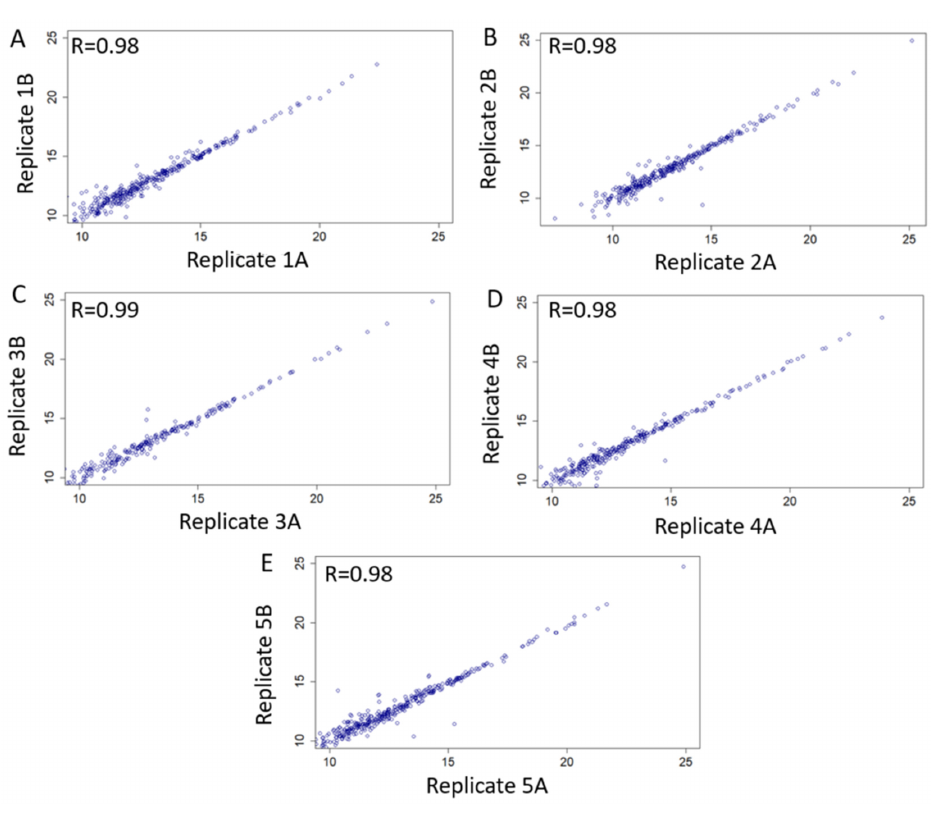
Figure 7. Technical validation and applicability of consensus cervico ‐ vaginal fluid spectral library based on five samples obtained from an independent cohort of post ‐ menopausal women at risk of endometrial cancer. Scatter plots of intensity correlation between replicates of all five validationsamples ( A – E ) using Pearson’s correlation analyses are as shown. The reproducibility of peptide identifications was subsequently summarised using coefficient of variations of transition intensities at a 1% peptide FDR. The median intra ‐ assay coefficient of variation for all replicates were <10 and is in keeping with expected technical variability (Figure 8).